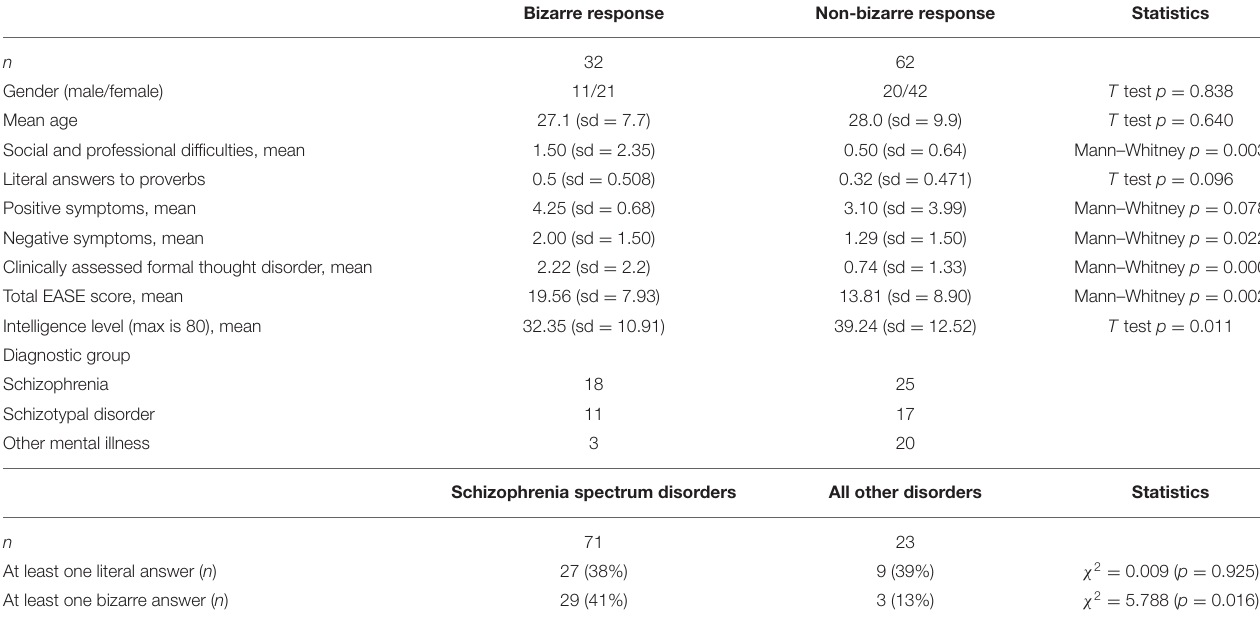
TABLE 2 | Sample description, psychopathology, and diagnostic